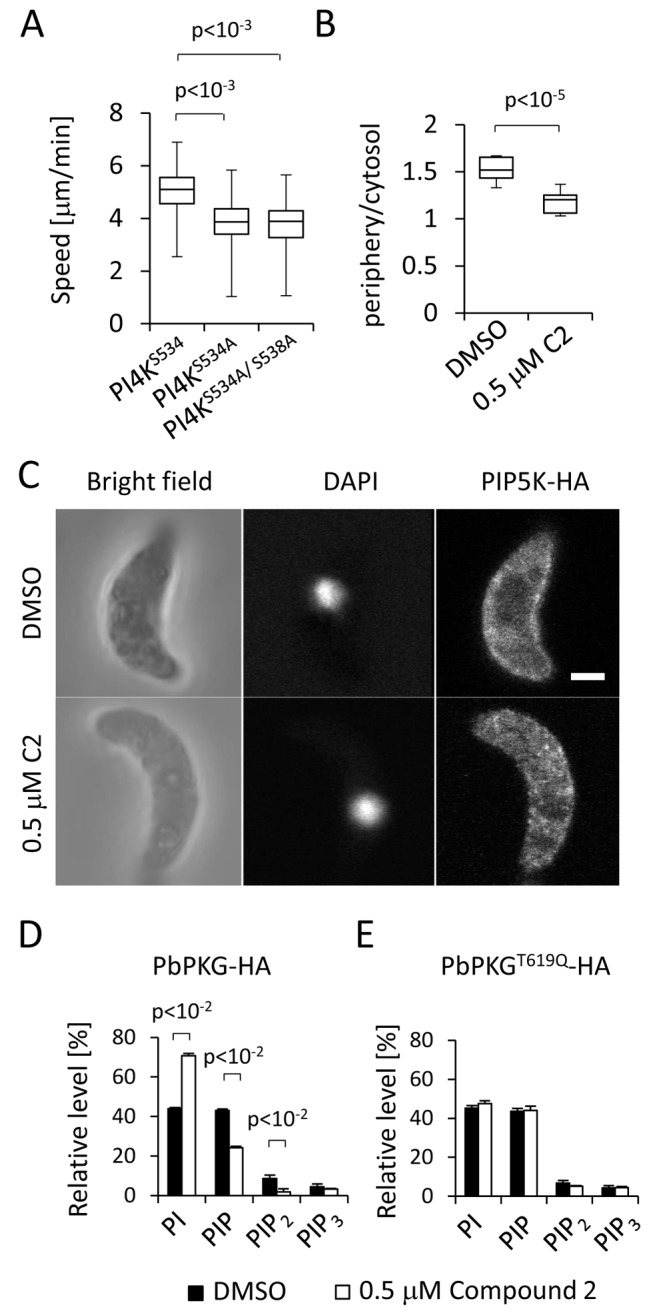
Phosphoinositide phosphorylation links PKG to gliding in P. berghei ookinetes.(A) Ookinete gliding speed of PI4KS534A and PI4KS534A/S538A ookinete mutants. Values are representative of 20 individual ookinetes from two independent biological replicates. (B) Ratio of peripheral to cytosolic fluorescence intensity from optical sections taken of different ookinetes from the experiment shown in (C); n = 10 sections from different ookinetes. Statistical analysis was carried out using a two-tailed t test. (C) Confocal immunofluorescence images of fixed ookinetes showing the effect of 0.5 µM C2 on the cellular distribution of a C-terminally HA tagged PIP5K (PBANKA_020310) expressed from its endogenous promoter. Scale bar, 5 µm. (D) Relative quantification of PI, PIP, PIP2, and PIP3 levels after 10 min treatment with 0.5 µM C2 or DMSO in PKG-HA ookinetes. (E) As in (D) but for PKGT619Q-HA ookinetes. Error bars in (D) and (E) show standard deviations of two biological replicates. The p values are from two-tailed t test. See also Figure S5.